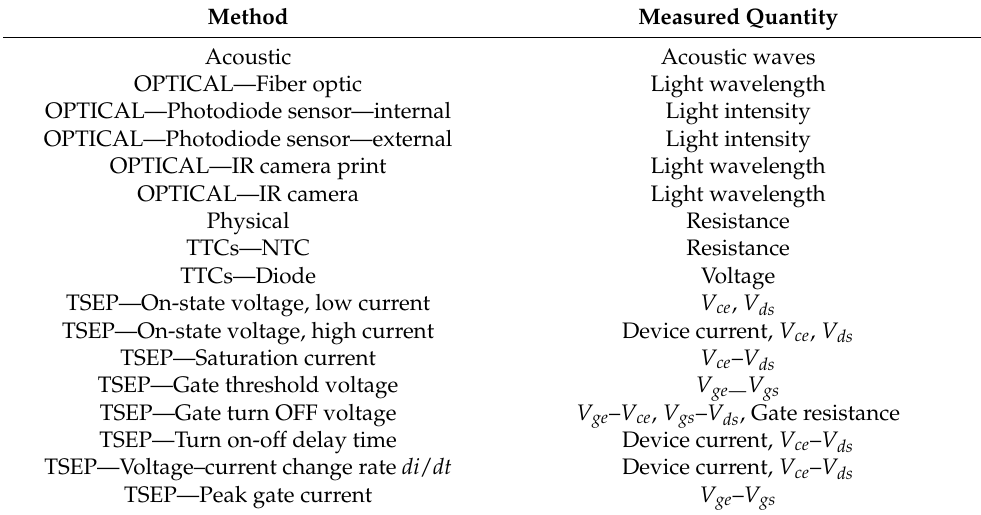
Table 1. Measured quantities for the different condition monitoring (CM) methods. IR, infrared; NTC, negative temperature coefficient; TTC, thermal test chip; TSEP, thermo-sensitive electrical